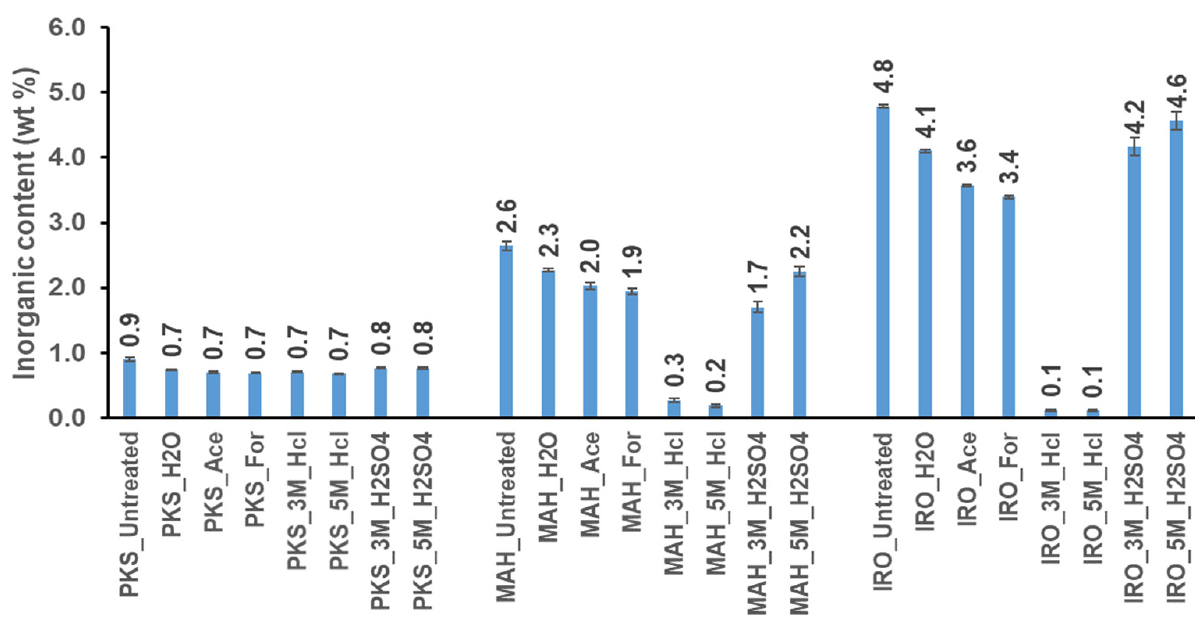
Figure 5. Inorganic content in weight (%) of raw and pretreated PKS, MAH and IRO.